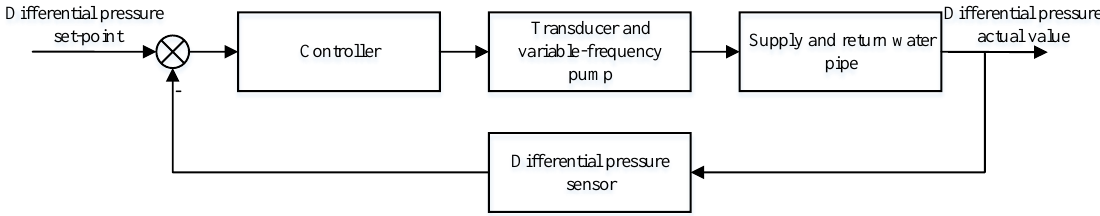
Figure 4. Structure of secondary pump constant differential pressure control.